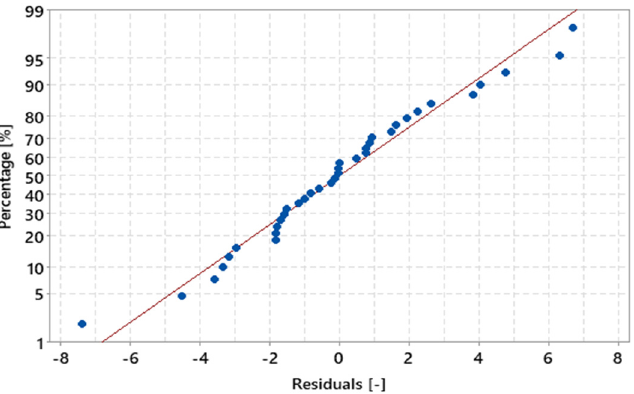
Figure 17. Percentage of MHSW fraction materials x residuals for the statistical analysis of gravimetric data of MHSW in the city of Belém-Pará-Brazil on 18 October 2021, 20 October 2021, 27 October 2021, and 29 October 2021.